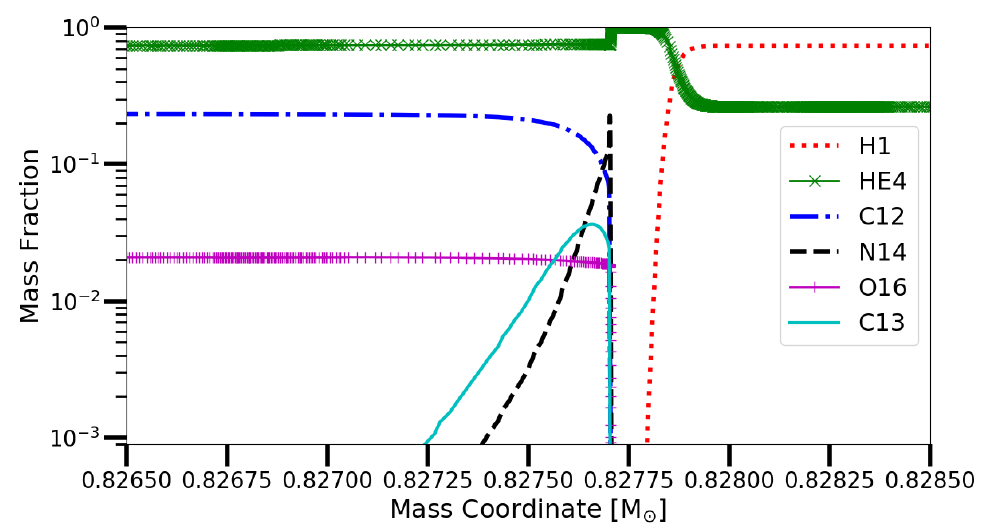
Figure 4. Upper panel: 13 C-pocket at the end of the oxygen-rich phase from m3z1m3. Lower panel: 13 C-pocket at the end of the oxygen-rich phase from m3z1m3-bigpoc. The comparison shows a much larger pocket formed by m3z1m3-bigpoc compared to m3z1m3 (about a factor of three) as a consequence of the slower decay of the mixing coefficient adopted for this model (see Table 2 for the mixing parameters